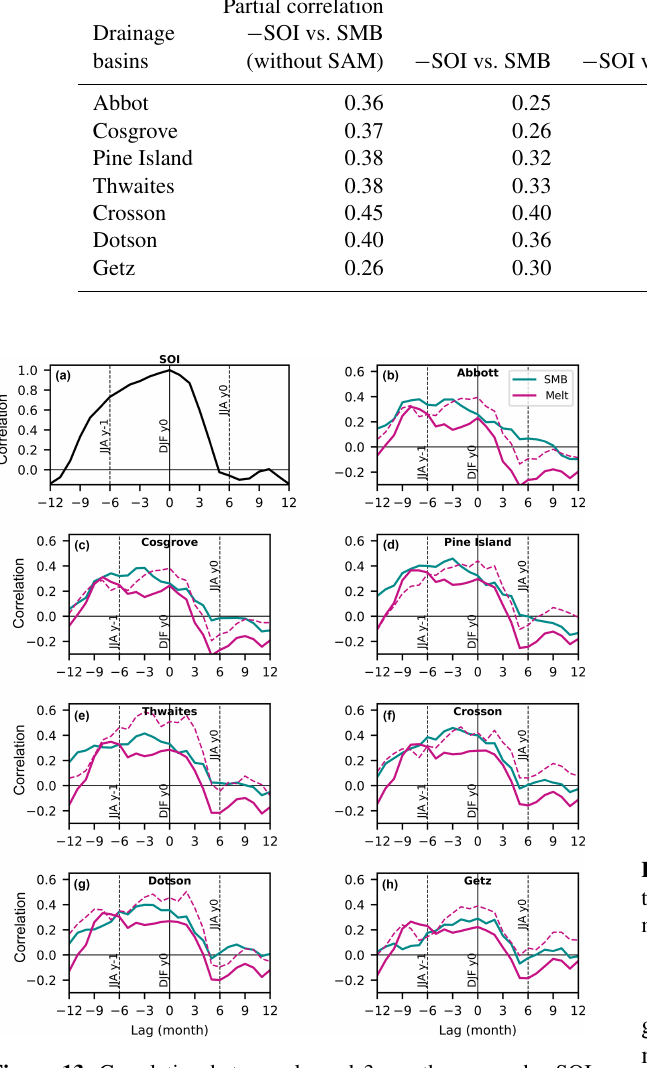
Figure 13. Correlation between lagged 3-month averaged − SOI (i.e. DJF at zero lag, previous JJA at − 6 lag) and (a) DJF SOI. (b–h) Simulated SMB and melt rates in individual drainage basins. The dashed curves correspond to the number of melt days derived from satellite data by Picard et al. (2007).